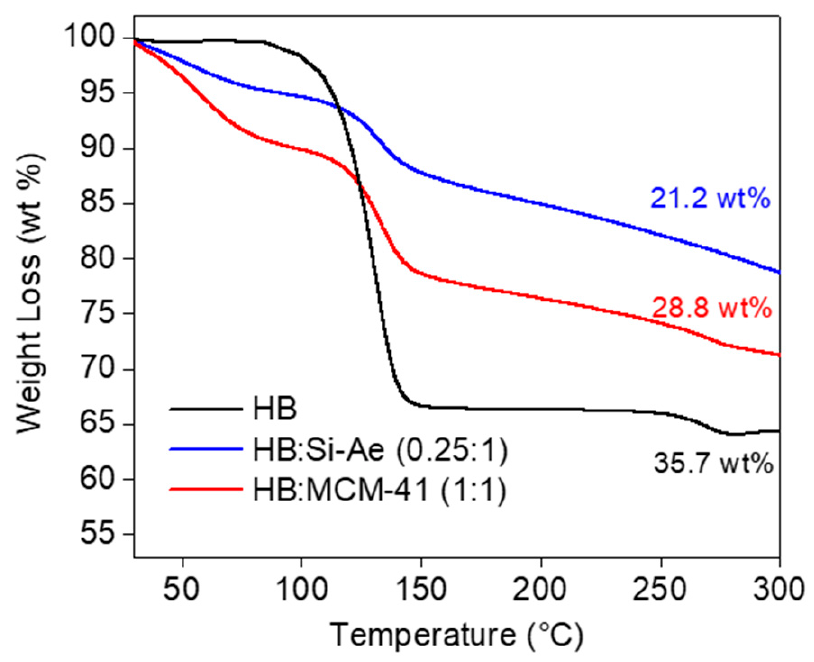
Figure 5. TGA results of HB, HB:MCM-41 (1:1) and HB:Si-Ae (0.25:1) at heating rate of 5 °C min − 1 . Decomposition Kinetics in HB:MCM-41 (1:1) and HB:Si-Ae (0.25:1) The dehydrogenation kinetics of bulk HB, HB:MCM-41 (1:1) and HB:Si-Ae (0.25:1)